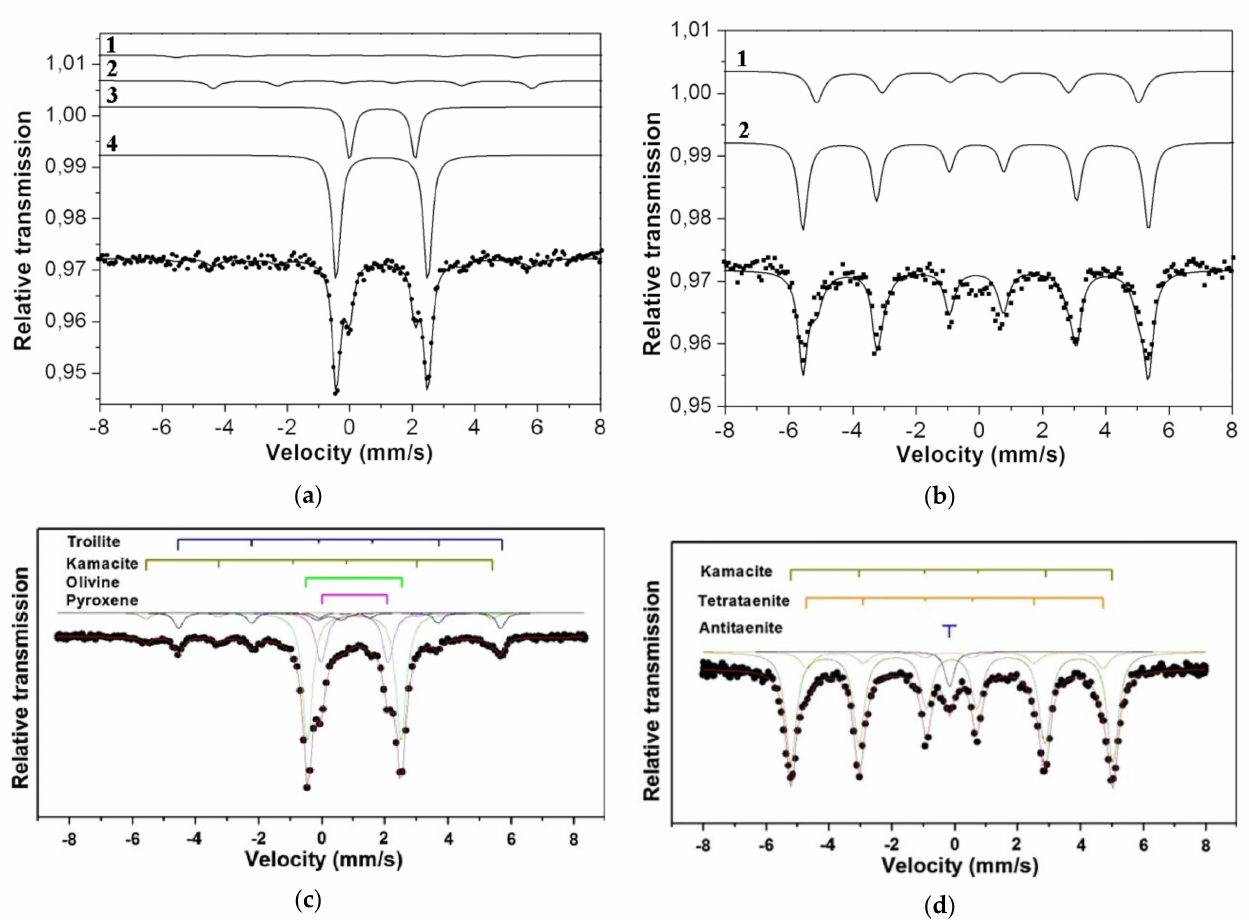
Figure 23. Room temperature Mössbauer spectra of equilibrated ordinary chondrites Villalbeto de la Peña L6 [88] ( a , b ) and Lavras do Sul L5 [89] ( c , d ): bulk material ( a , c ) and extracted metal fraction ( b , d ). Indicated components are the results of the fits. Adapted from References